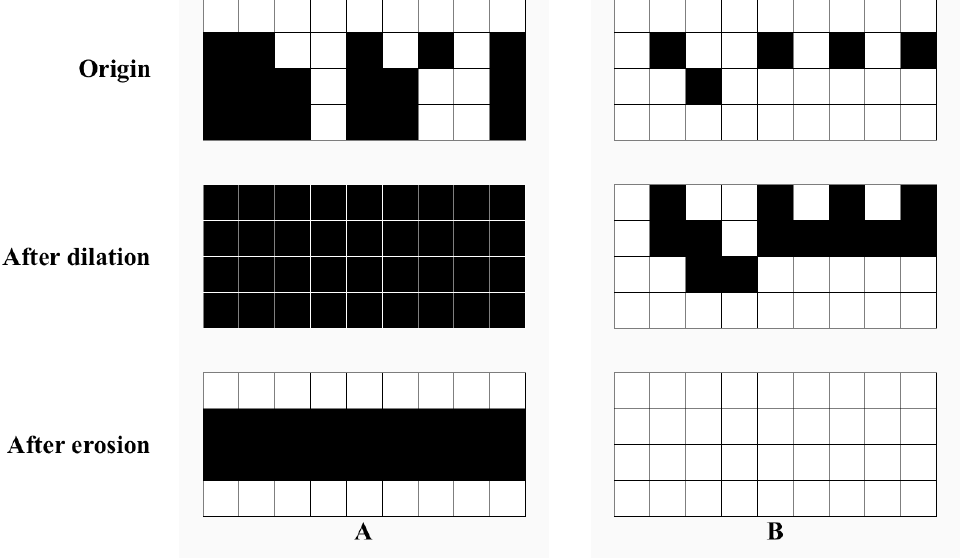
Figure 6. Process of morphology module reduces the number of connected domains and re- moves noise. ( A ) Large noise in the segmentation; ( B ) Small noise in the